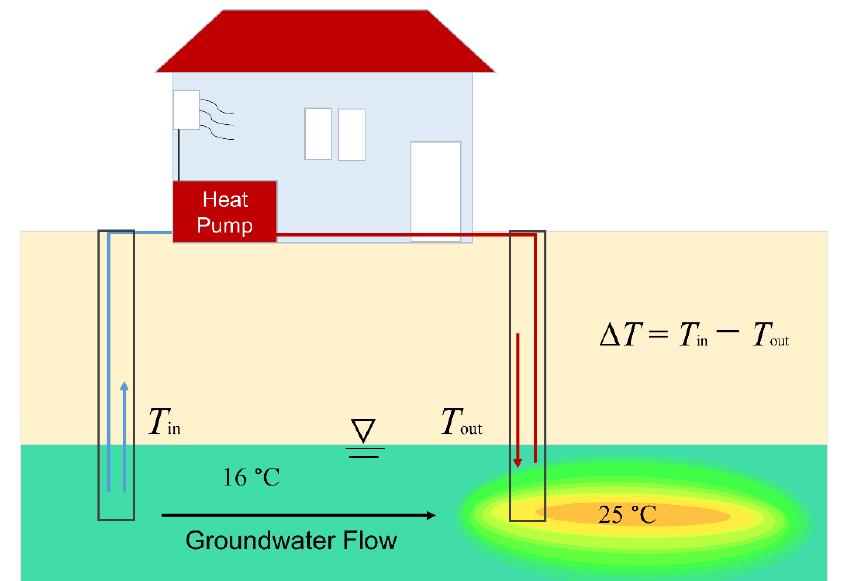
Figure 1. Schematic image of an open-loop geothermal heat pump